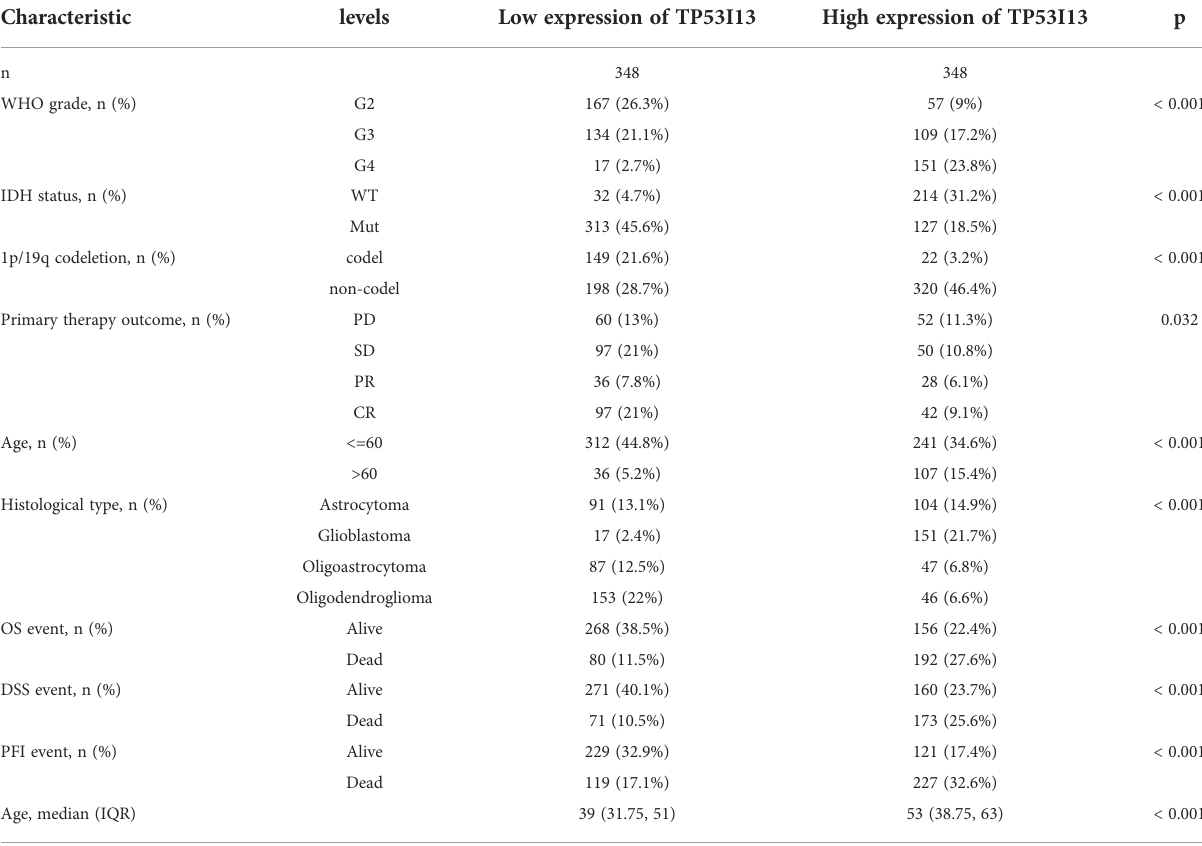
TABLE 2 The relationship between TP53I13 expression and different clinical factors based on TCGA. Characteristic